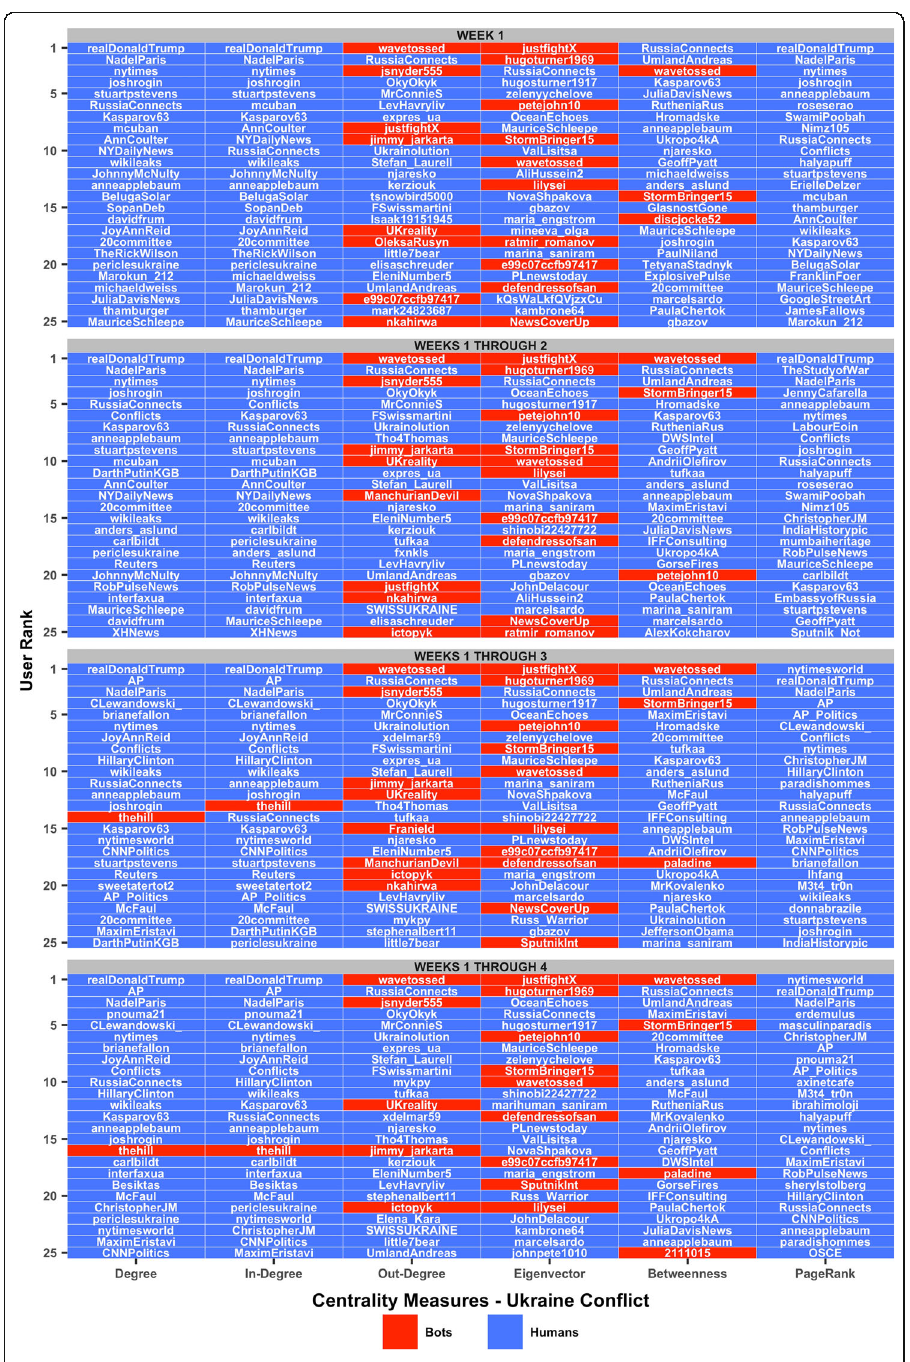
Fig. 6 Centrality ranking of top-25 bot (red) and human (blue) users over a cumulative four-week period for the Ukraine Conflict OSN conversation for six centrality measures: (1) degree, (2) in-degree, (3) out-degree, (4) eigenvector, (5) betweenness and (6)